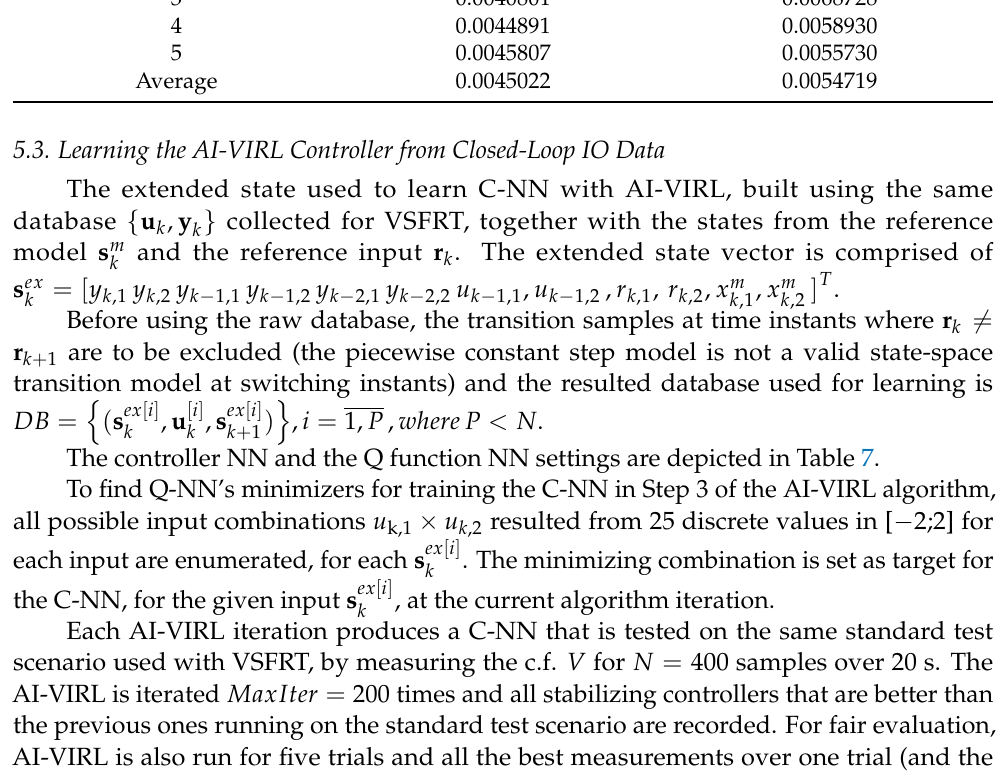
Trial VSFRT AI-VIRL (500